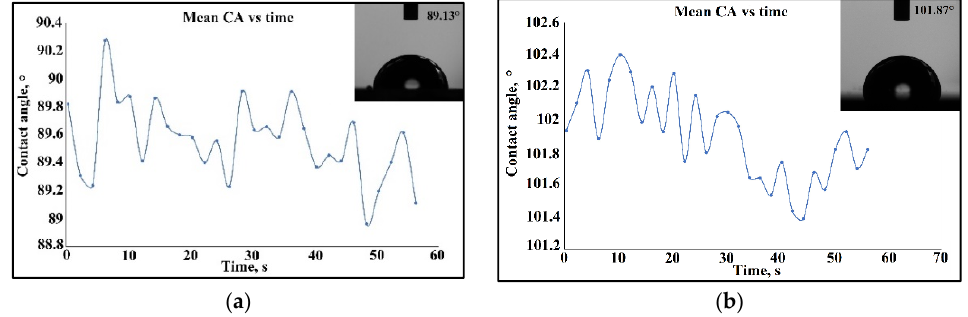
Figure 13. The contact angle measurement of the samples coated with a thin film of Ta 2 O 5 by e-gun technology: ( a ) Sample S2 of the Co–Cr alloy fabricated via the DMLS process; ( b ) Sample S1 of the cast 304L stainless steel.